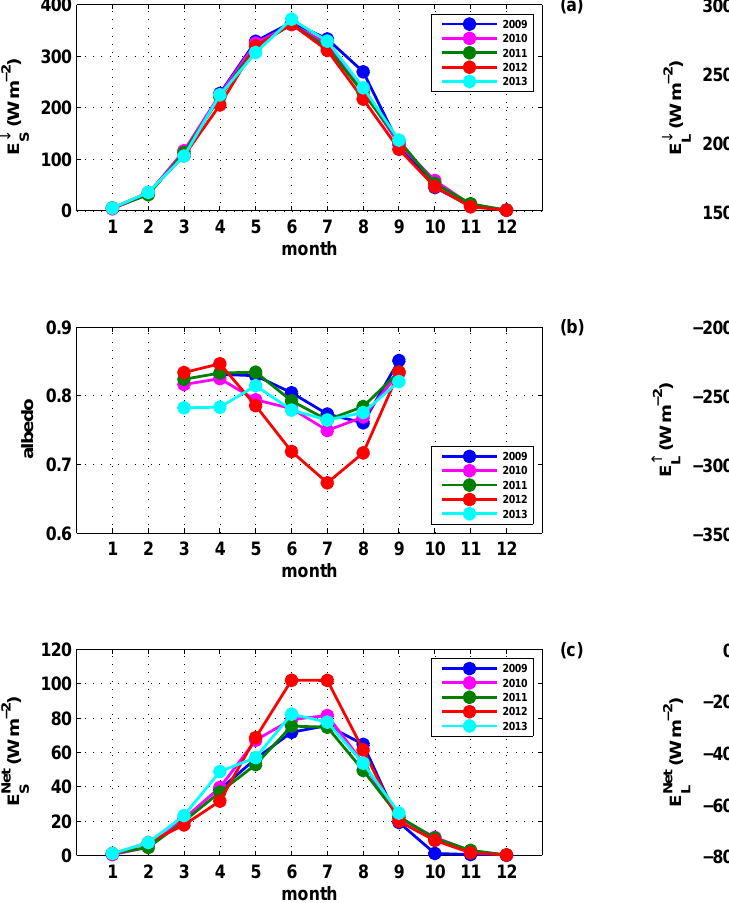
Figure 6. Seasonal cycles for the years 2009–2013 based on monthly averages of (a) incoming, (b) emitted, and (c) net long- wave energy